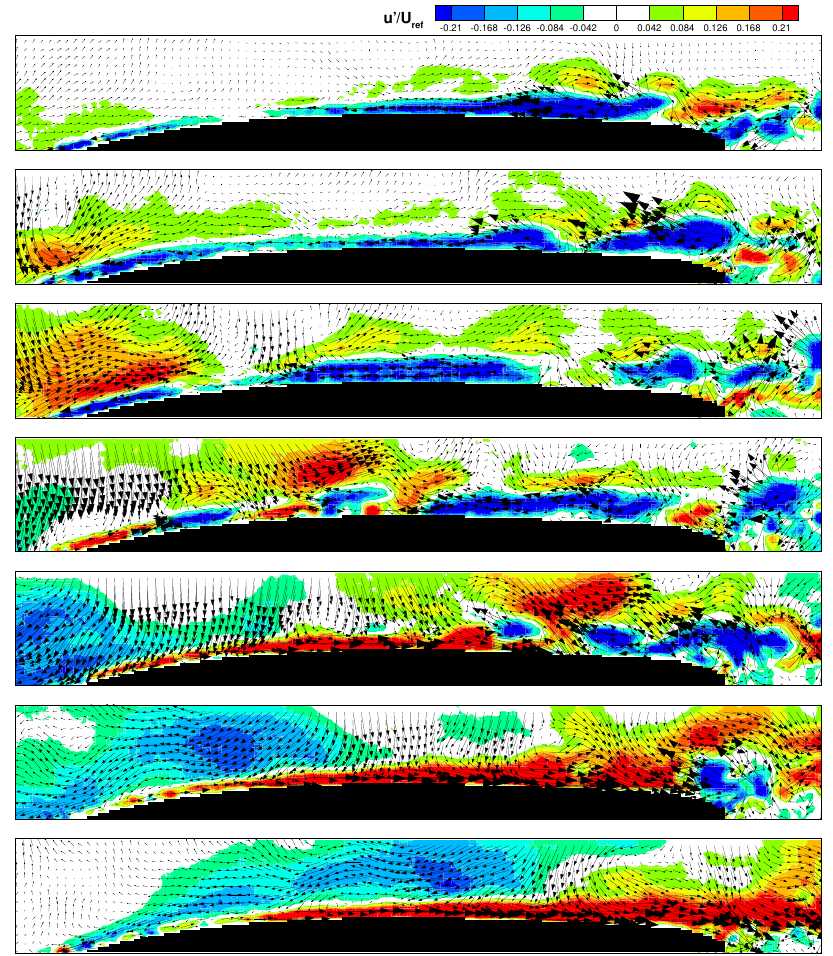
Figure 3. Time series of the instantaneous perturbation velocity, 0.5 f + case. The time interval between each snapshot is 0.06 of the wake passing period (five times larger than the time-resolved particle image velocimetry (TR-PIV) temporal